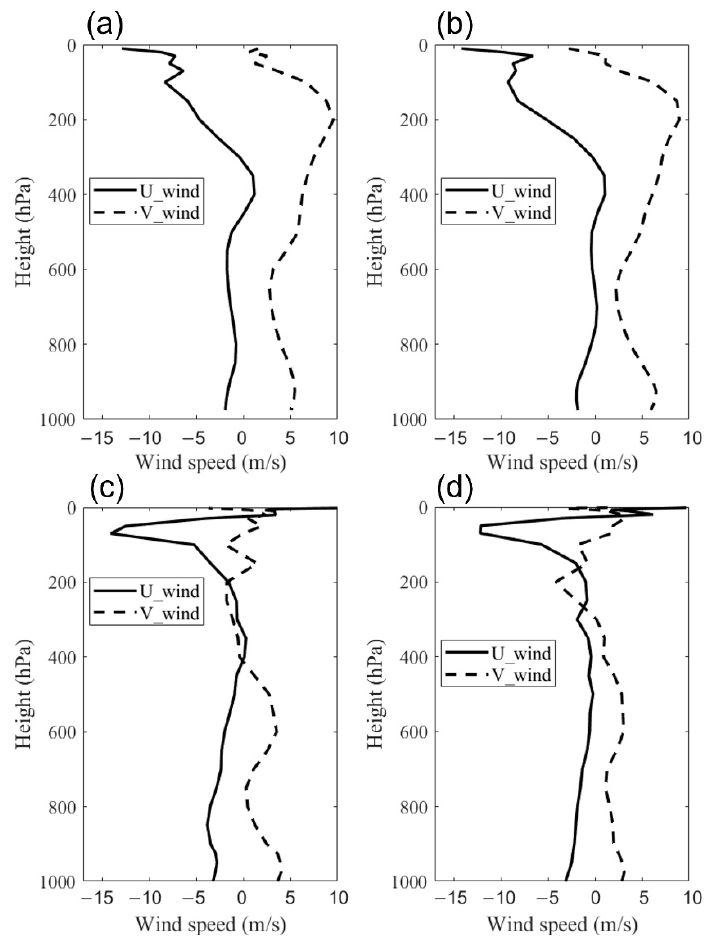
Figure 7. Variation in 200–800 km mean meridional (U_wind)(m/s) and zonal (V_wind)(m/s) winds at ( a ) 10:12, May 2002, ( b ) 10:18, May 2002, ( c ) 14:06, October 2018, and ( d ) 14:12, October 2018.